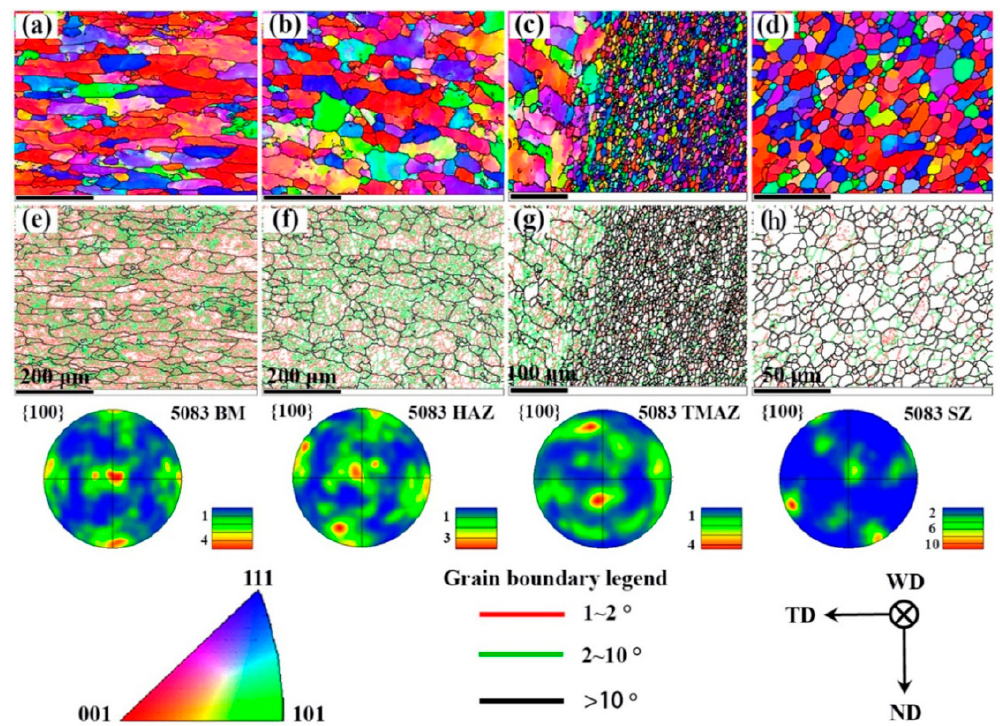
Figure 9. EBSD orientation maps and grain boundaries of the dissimilar AA5083-AA2024 aluminum alloy joint on the AA5083 side: ( a , e ) BM, ( b , f ) HAZ, ( c , g ) TMAZSZ interface and ( d , h ) SZ, reproduced from [91], with permission from Elsevier, 2019.